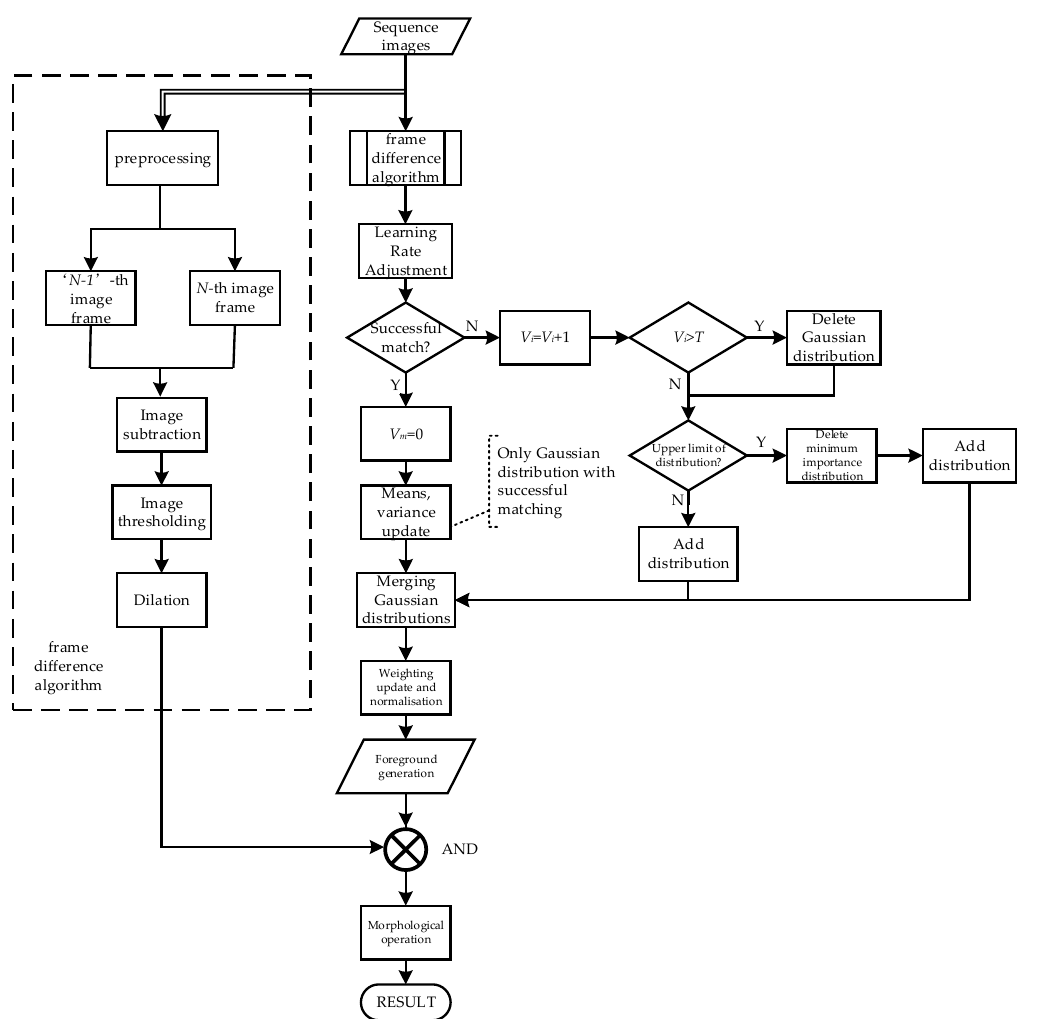
Figure 6. The flow diagram of the detection